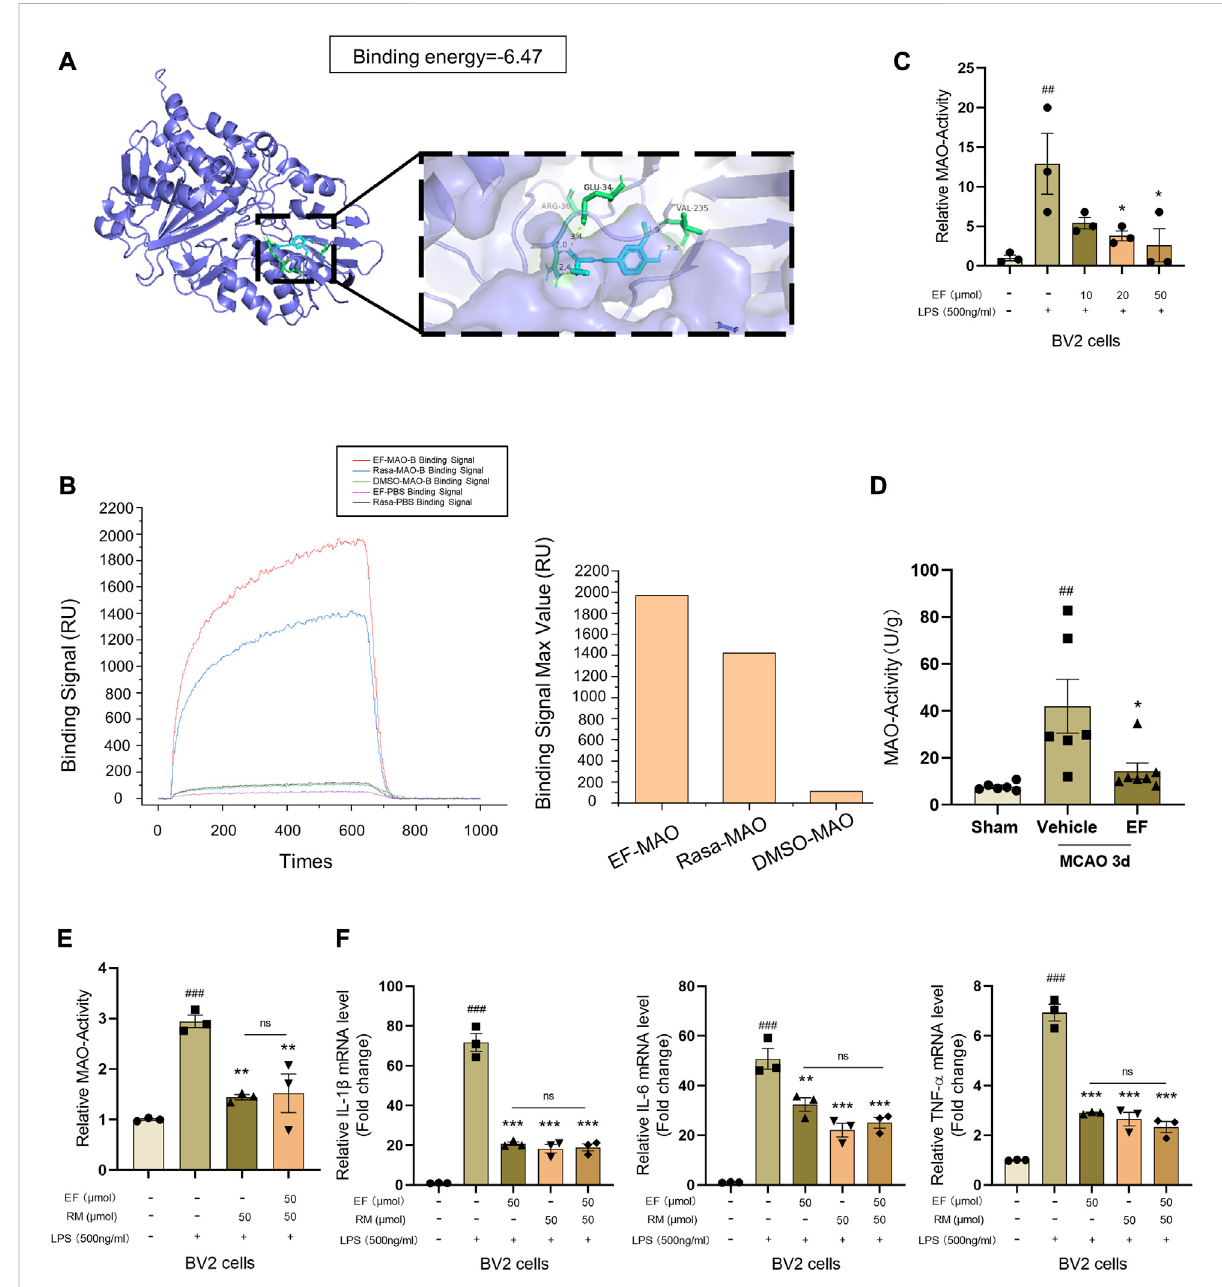
FIGURE 5 EF suppresses pro-in fl ammatory response by targeting MAO-B. (A) Crystal structures and binding energy of MAO-B in complex with EF predicted by Autodock software. (B) Protein (hMAO-B)-ligand (EF/RM) interaction and af fi nity analysis were conducted by Surface Plasmon Resonance (SPR), DMSO was used as a negative control. (C – E) BV2 cells were treated with/without EF or RM for 2 h, then stimulated with LPS (500 ng/ml) for additional 3 h. MAO-activity of treated cells ( n = 3/group) and infarcted lateral hemisphere homogenate from grouped mice ( n = 6 – 7/group) as above were tested using MAO Activity Colorimetric Assay Kit. (F) Total mRNA of treated BV2 cells was isolated and the mRNA levels of IL-1 β , IL-6 and TNF- α were analyzed using RT-qPCR. Values are shown as the mean ± SEM. ## p < 0.005, ### p < 0.001 compared